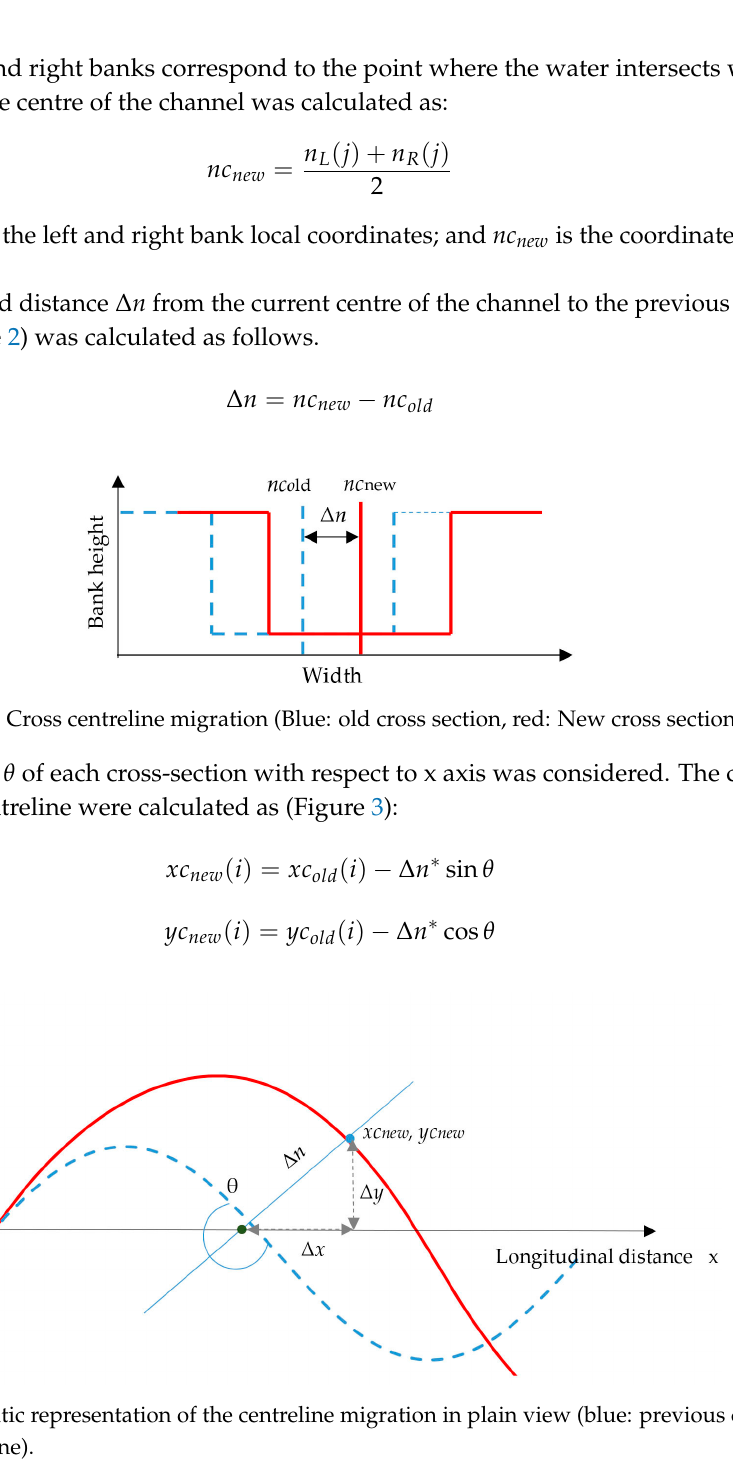
Figure 3. Schematic representation of the centreline migration in plain view (blue: previous centreline, red: new centreline).